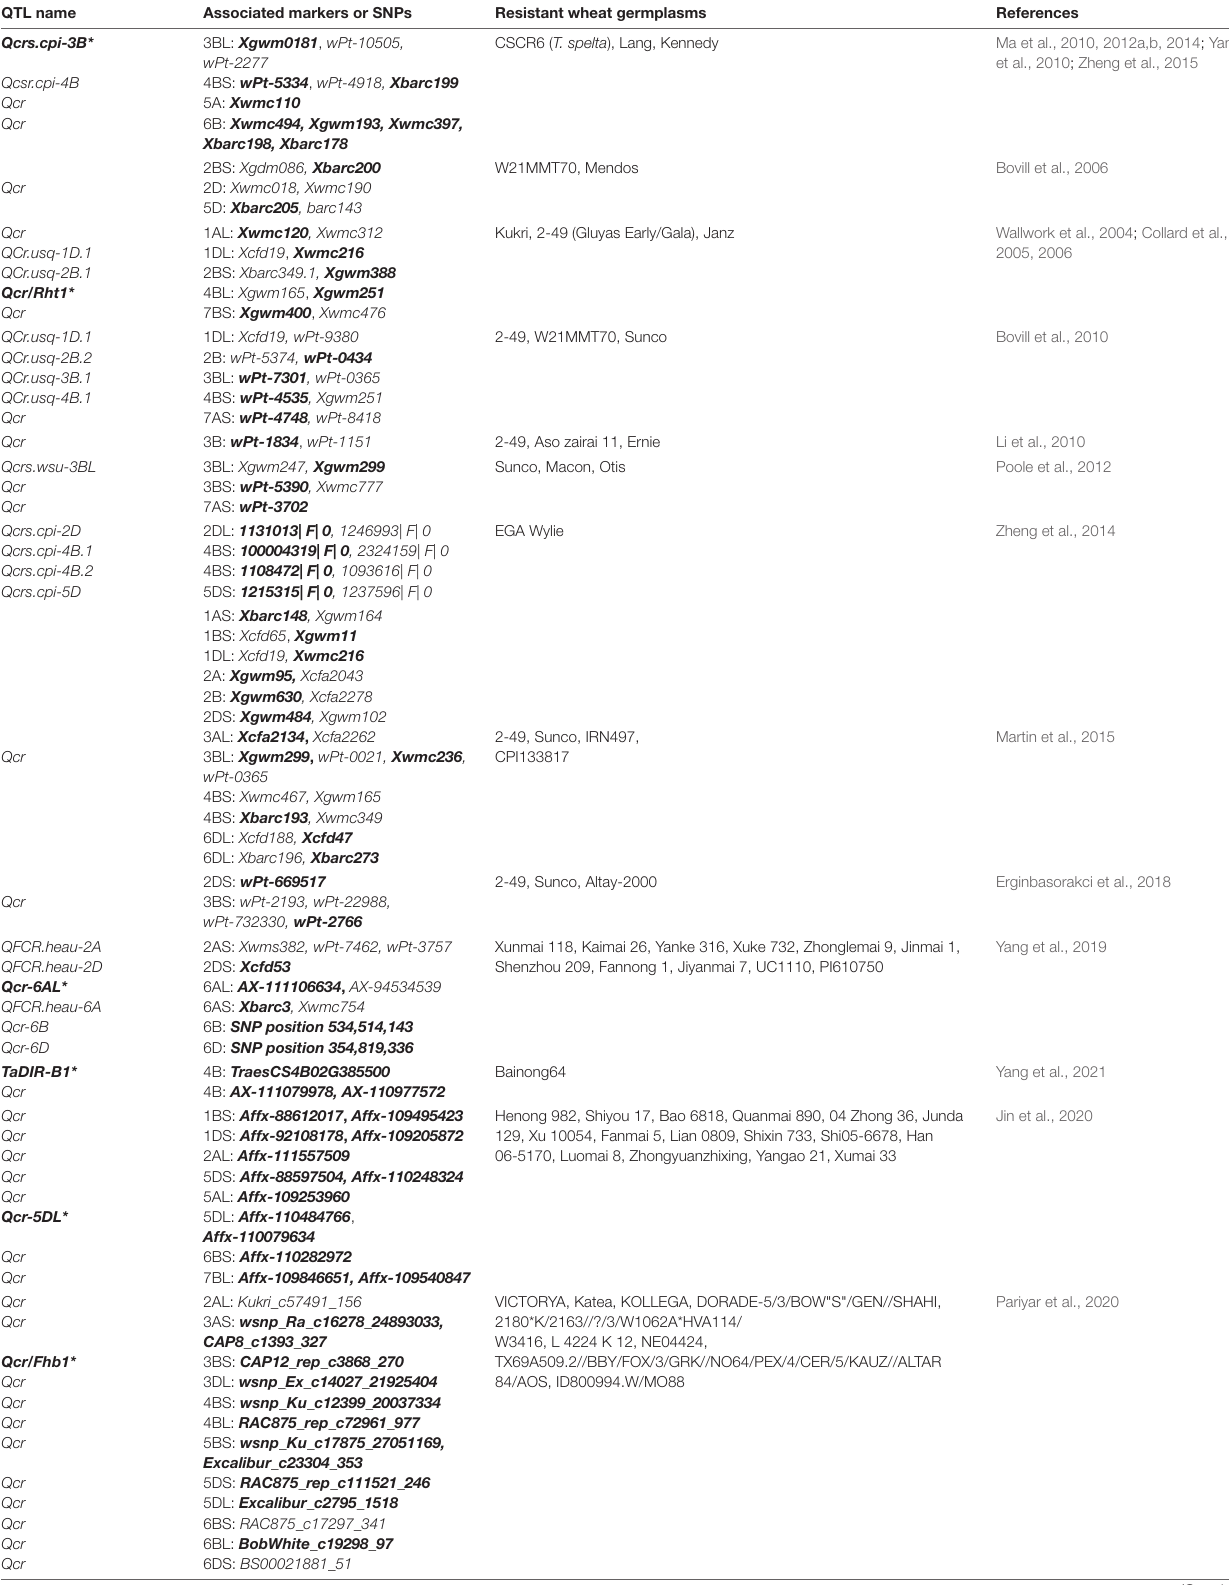
TABLE 2 | Genetic loci controlling wheat resistance to Fusarium crown